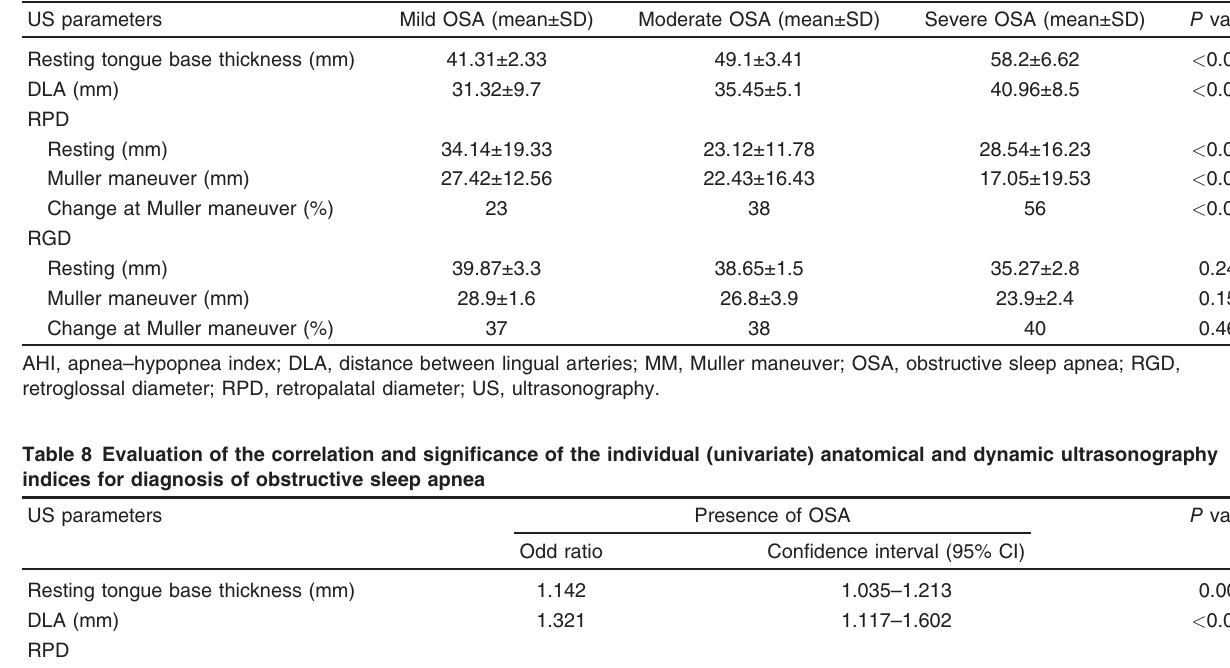
Table 7 Comparison between ultrasonography anatomical and dynamic changes and obstructive sleep apnea severity US parameters